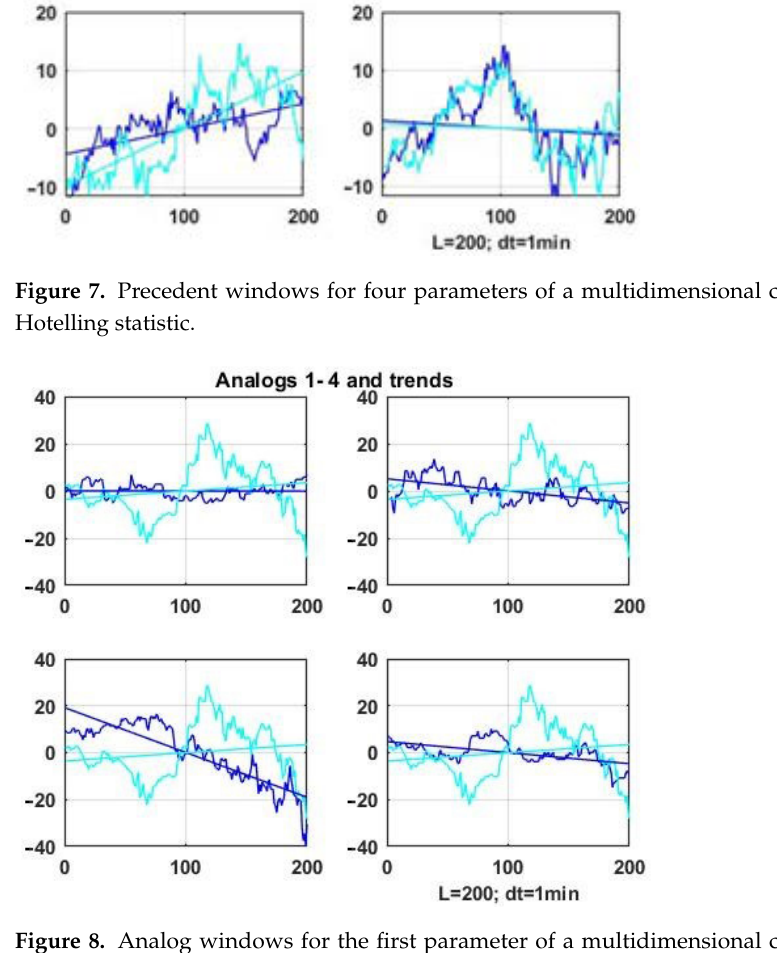
Figure 7. Precedent windows for four parameters of a multidimensional chaotic process by the Hotelling statistic.